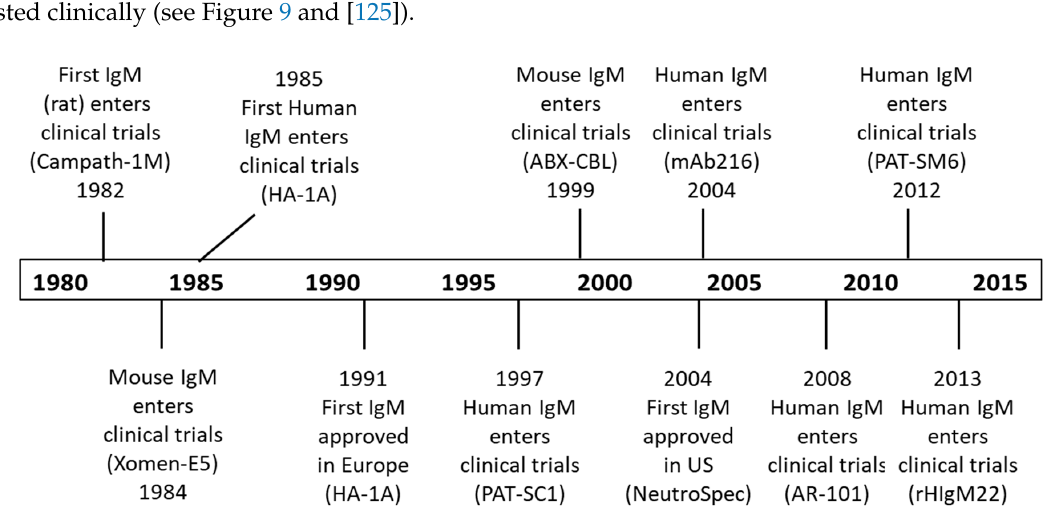
Figure 9. History of selected IgM human clinical trials.